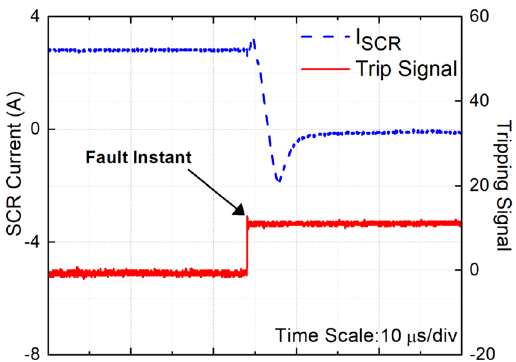
Figure 7. A fault current of 3 A cutoff under 240 V power supply (SCR current, in blue dashed line; fault tripping signal, in red solid line).